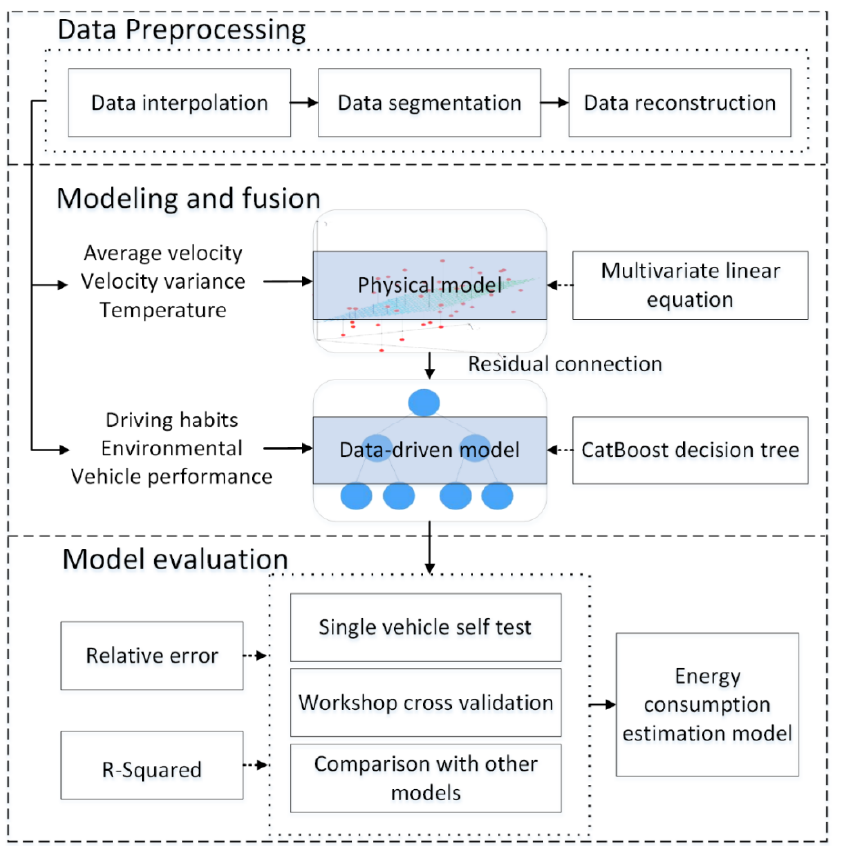
Figure 5. Flow chart of the energy consumption fusion modeling approach.